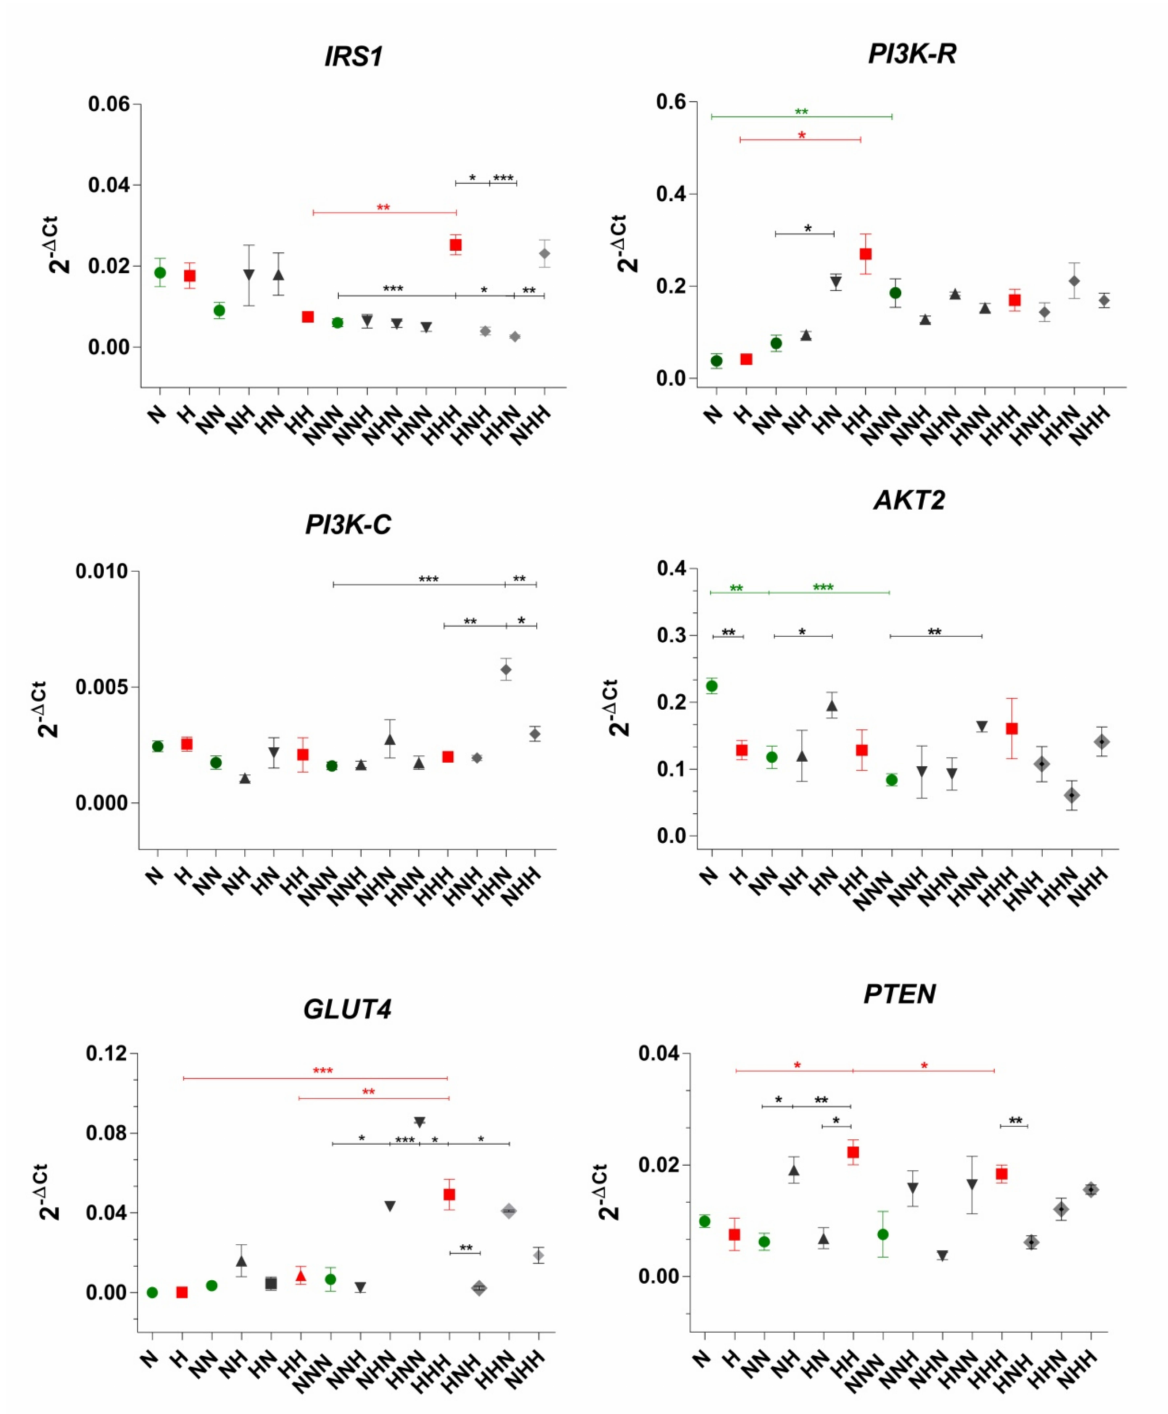
Figure 1. mRNA expression levels of IRS1, PI3KR, PI3KC, PTEN, AKT2 , and GLUT4 evaluated after completion of proliferation, differentiation, and maturation of visceral cellscultured in chronic/intermittent normoglycemic (N) and hyperglycemic (H) conditions. Data are expressed as mean ± SEM in green (NG), red (chronic HG), dark grey (single HG hit), and light grey (double HG hit). Differences in expression levels between two particular culture variants were evaluated using a two-tailed t -test. One-way ANOVA with a post-hoc Tukey test was used for the calculation of statistical significance of changes observed during ADG in NG and HG. (***): p ≤ 0.001; (**): p ≤ 0.01; (*): p ≤